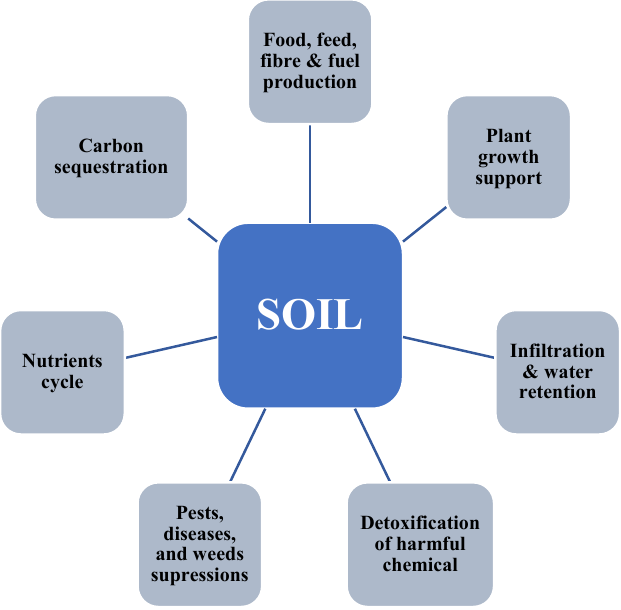
Figure 1. Main functions of soil (Adapted from [7]).